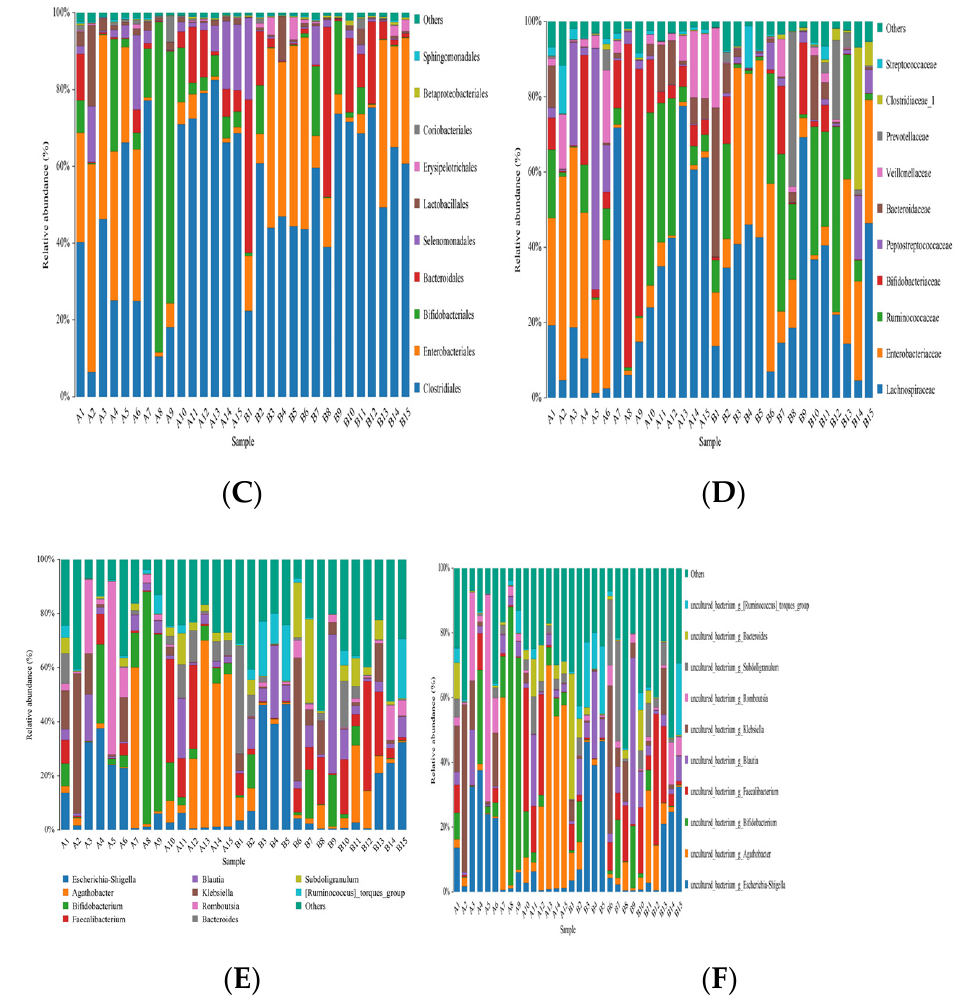
Figure 18. The histogram of species distribution of each sample at the levels of phylum, class, order, family, genus, and species in Figures ( A – F ).